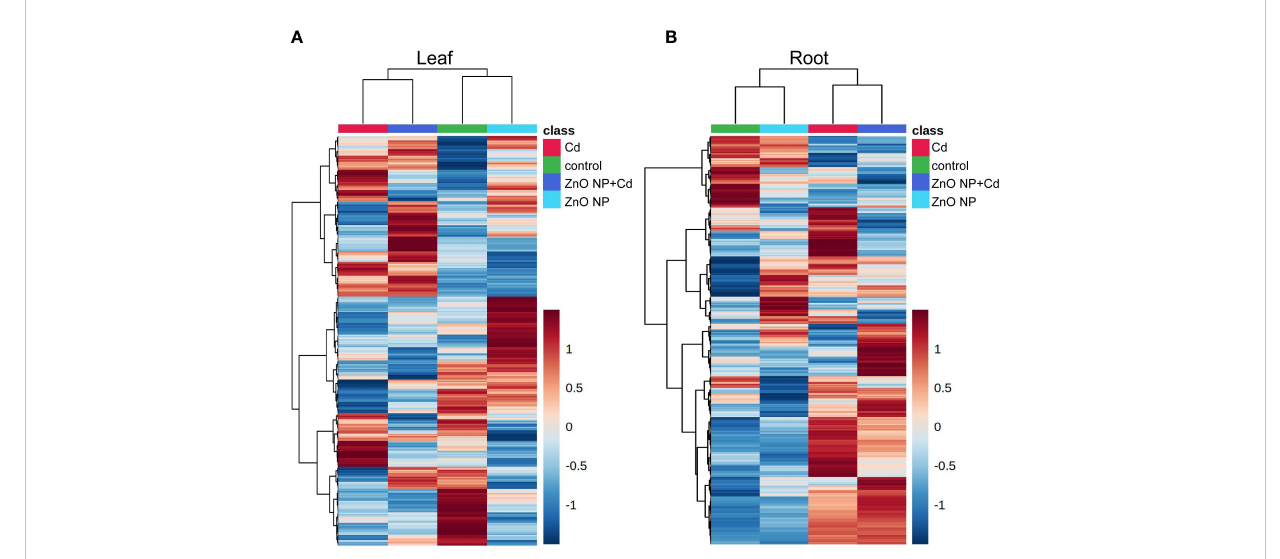
FIGURE 4 Metabolomic analysis identi fi ed the differentially accumulated metabolites in the leaves (A) and roots (B) of tomato seedlings.